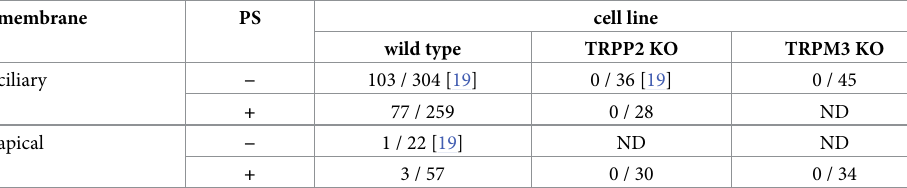
Table 1. Incidences of TRPP2-dependent channels in apical and ciliary